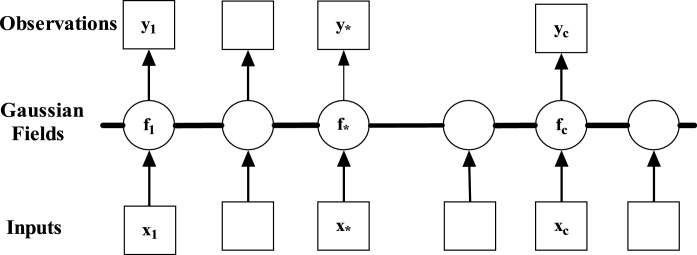
Graphical representation of GPR [21].